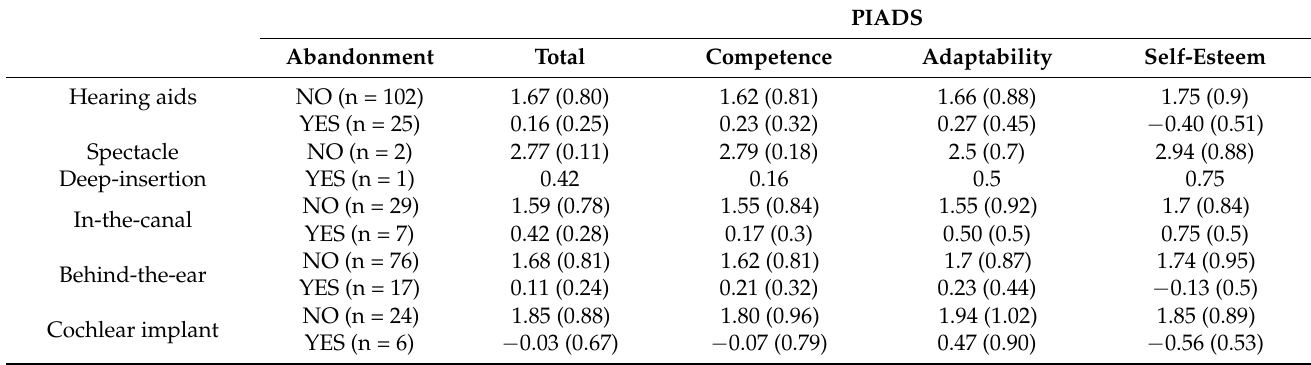
Table 3. Scores on the PIADS scale and its three subscales according to whether or not participants had abandoned their hearing aid (n = 127) or cochlear implant (n = 30).